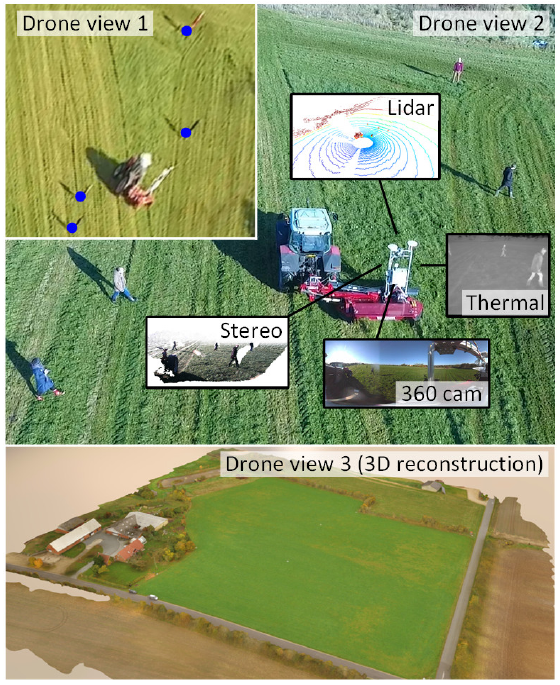
Figure 1. Recording platform surrounded by static and moving obstacles. Multiple drone views record the exact position of obstacles, while the recording platform records local sensor data. Table 1. Comparison to existing datasets in robotics and